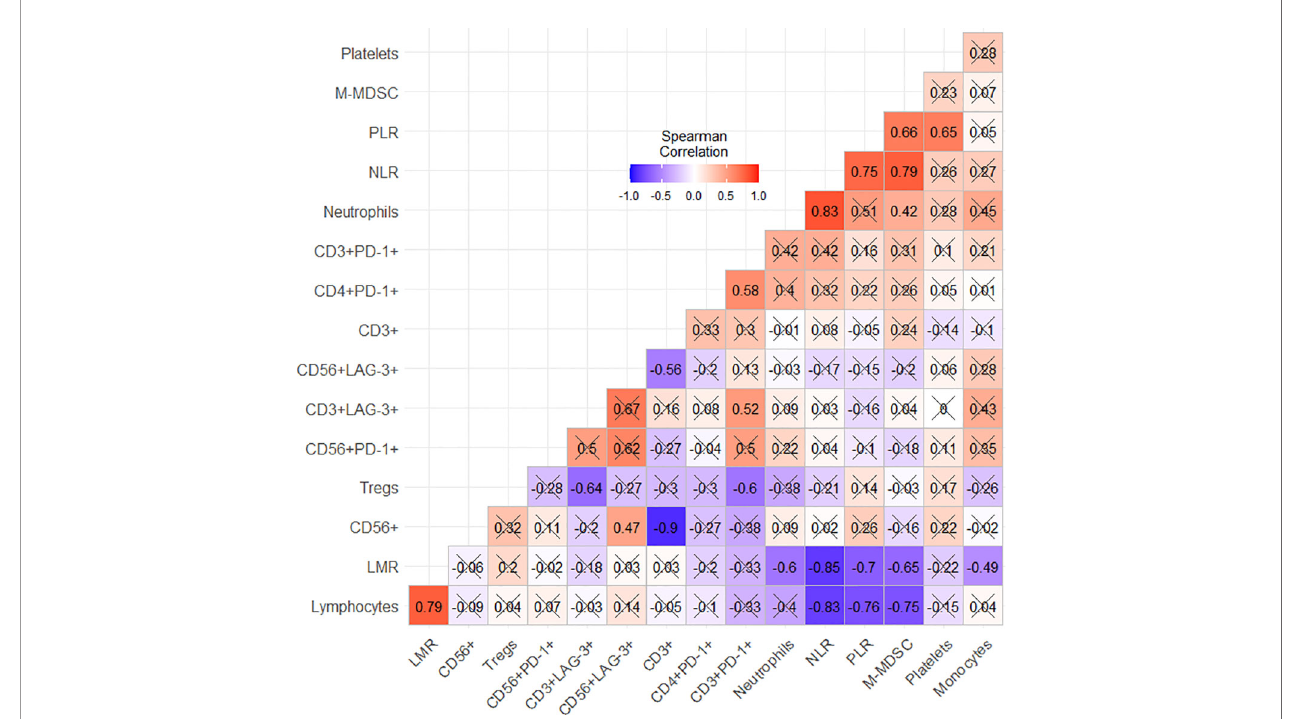
FIGURE 4 | Spearman ’ s correlation coef fi cients. “ X ” refers to a not statistically signi fi cant correlation (p < 0.05).